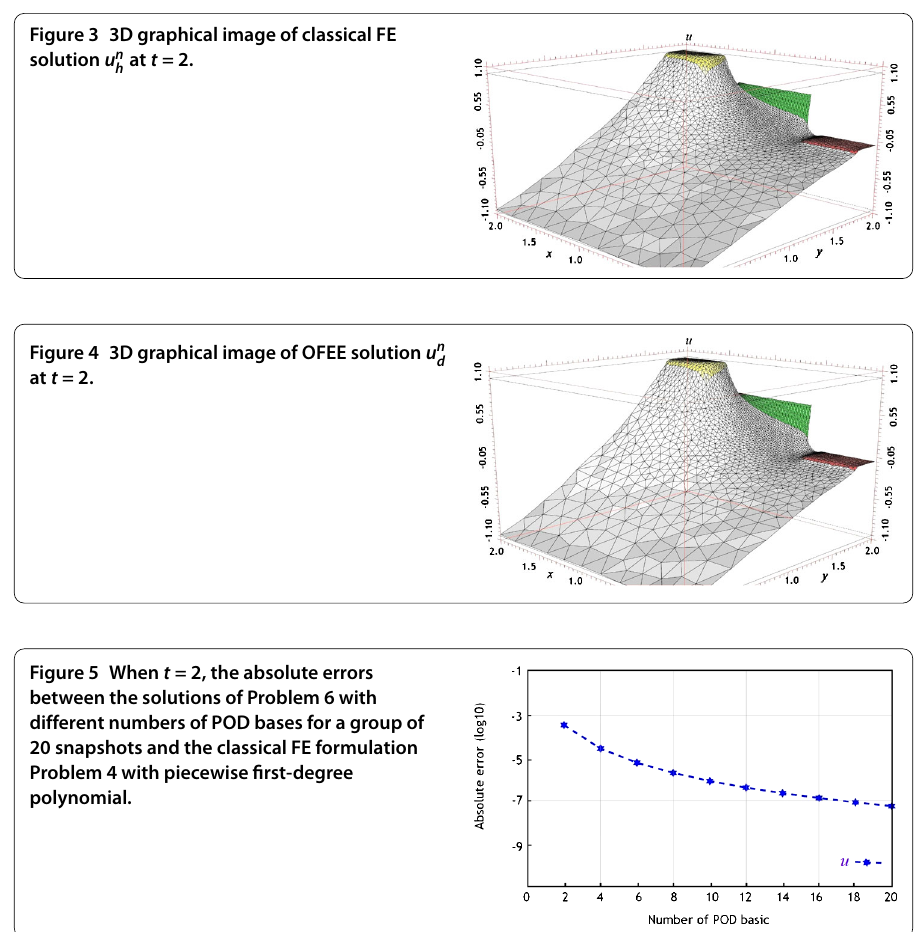
Figure 3 3D graphical image of classical FE solution u n at t = 2. h